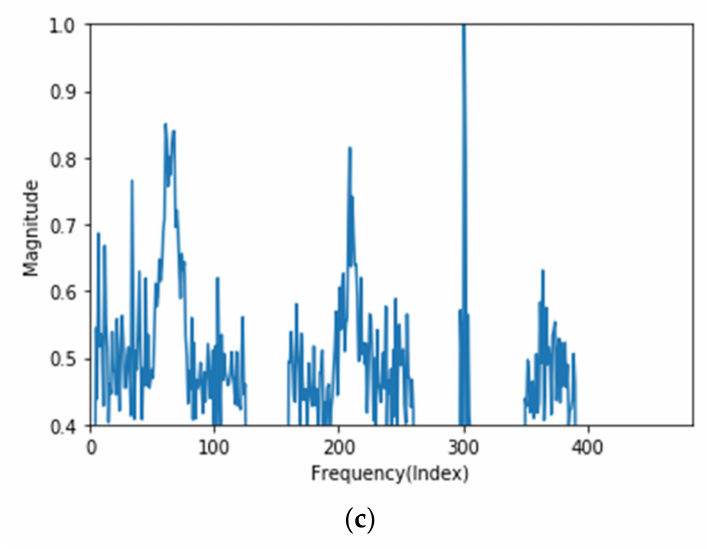
Figure 3. Generated error data: ( a ) first-order error data, ( b ) second-order error data, and ( c ) third- order error